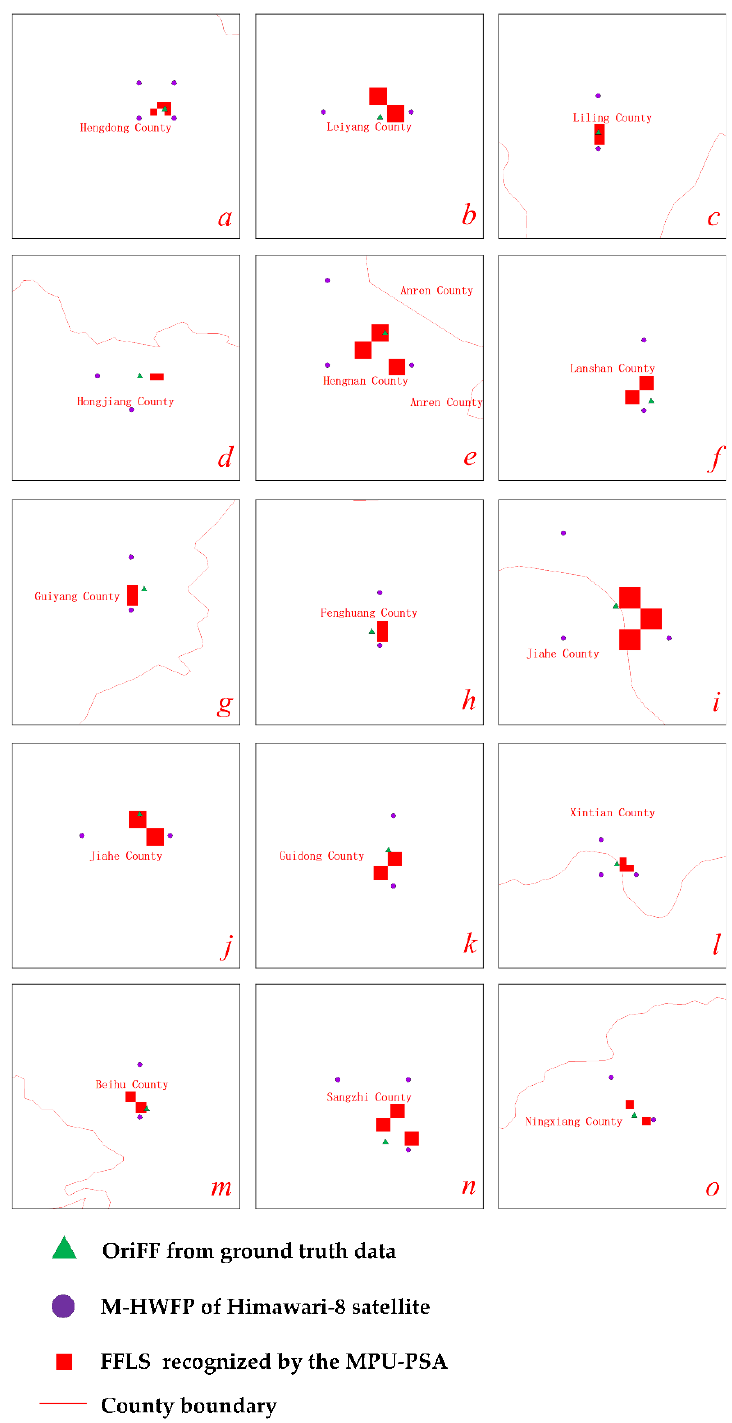
Figure 5. Positioning-accuracy comparison between M-HWFP and FFLS in detecting fire locations in various counties. OriFF represents origin of forest fire. The location-detection of the forest fires occurred in ( a ) Hengdong County (1HeCo), ( b ) Leiyang County (2LeCo), ( c ) Liling County (3LiCo), ( d ) Hongjiang County (4HoCo), ( e ) the junction of Hengnan County and Anren County (5HeCo), ( f ) Lanshan County (6LaCo), ( g ) Guiyang County (7GuCo), ( h ) Fenghuang County (8FeCo), ( i ) Jiahe County (9JiCo), ( j ) Jiahe County (10JiCo), ( k ) Guidong County (11GuCo), ( l ) Xintian County (12XiCo), ( m ) Beihu County (13BeCo), ( n ) Sangzhi County (14SaCo), and ( o ) Ningxiang County (15NiCo).